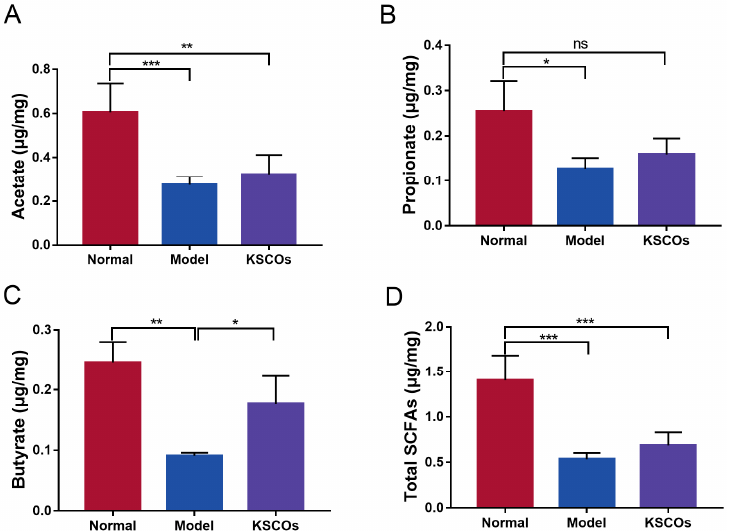
Figure 8. Concentrations of SCFAs in fecal samples: ( A ) the concentration of acetate in each group; ( B ) the concentration of propionate in each group; ( C ) the concentration of butyrate in each group. ( D ) the concentration of total SCFAs in each group. Data are shown as means ± SD, * p < 0.05, ** p < 0.01, *** p <